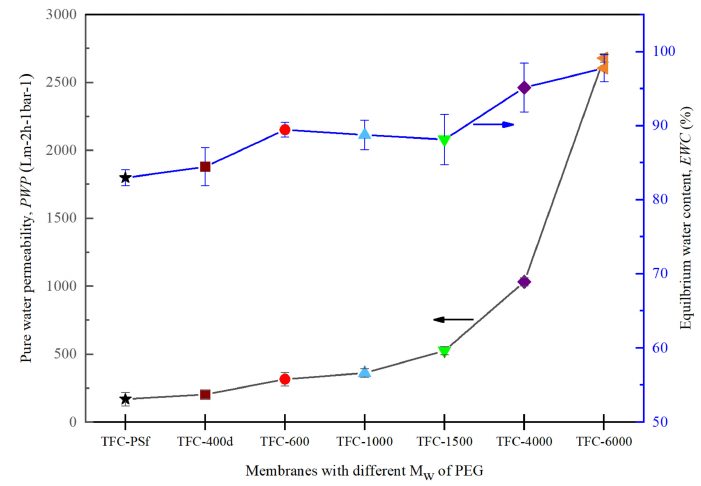
Figure 8. Pure water permeability, PWP , and equilibrium water content, EWC , of the modified TFC membranes with different M w s of PEG.